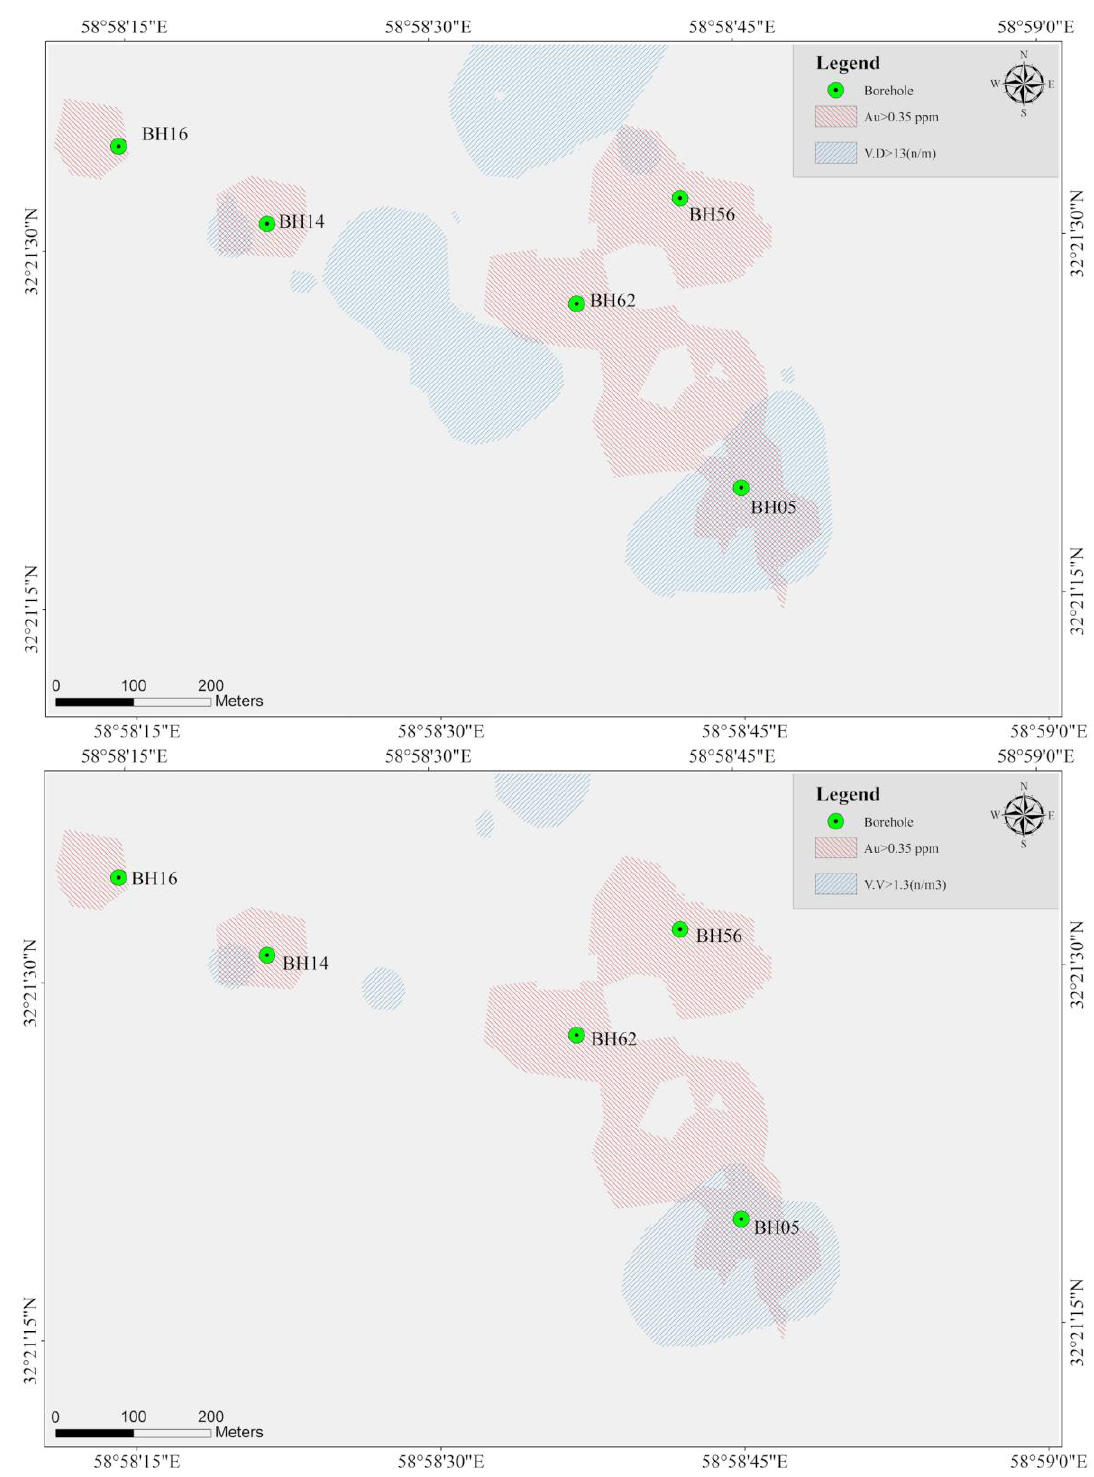
Figure 12. Lithogeochemical gold anomalies map and location of boreholes located on anomalies. To evaluate high grade Au anomalies and high V.D/high V.V maps, the term “ productivity ” was applied to a more precise definition of good and poor boreholes. The following formula is used to define the productivity of each borehole [78]: